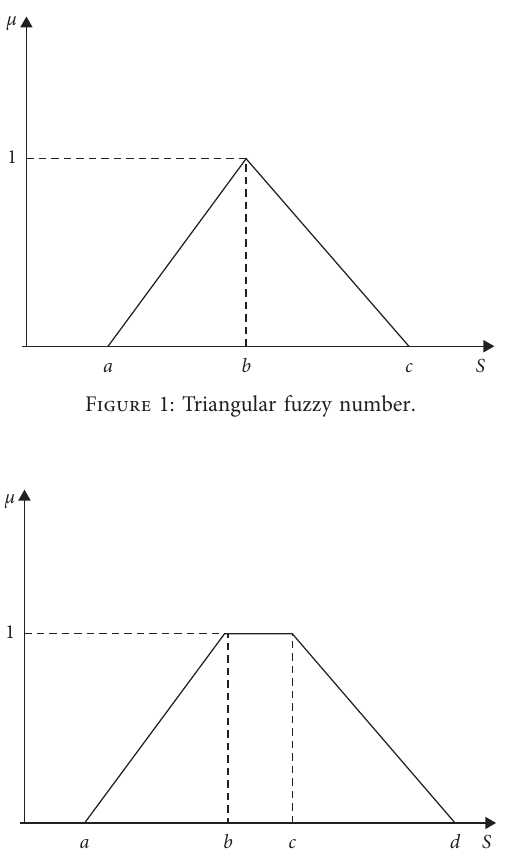
Figure 2: Trapezoidal fuzzy